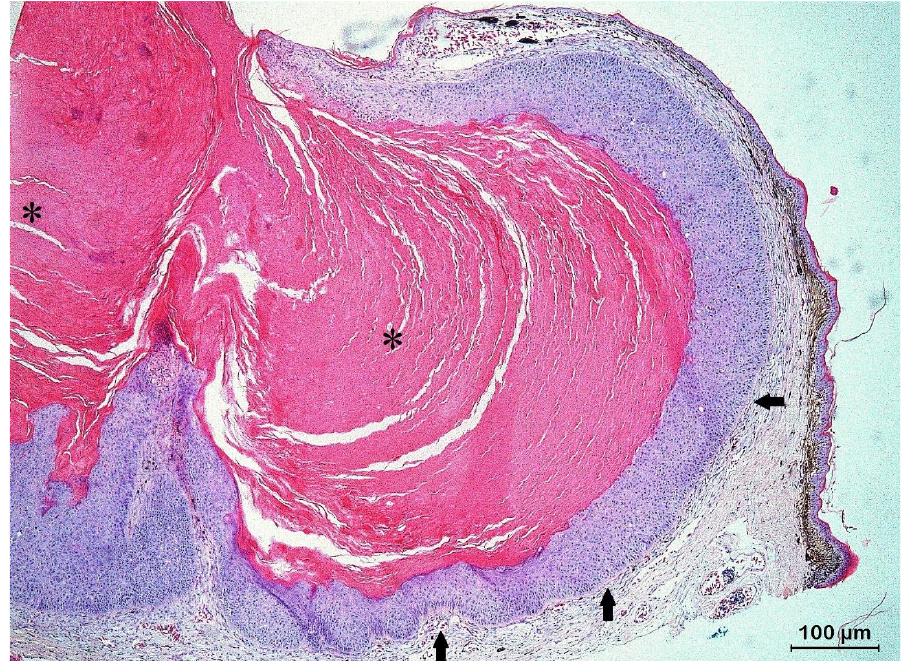
Figure 4. Histologic section of a keratoacanthoma (KA) from the dorsolateral body wall in a veiled chameleon ( Chamaeleo calyptratus ) showing a characteristic architectural pattern consisting of an exo-endophytic, cyst-like invagination of the epidermis that creates a crateriform lesion with a central keratinous plug (asterisks) and minimally infiltrating borders (arrows).